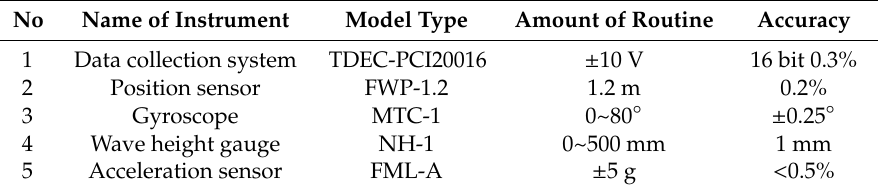
Table 2. Principle dimensions and parameters of the towing tank.